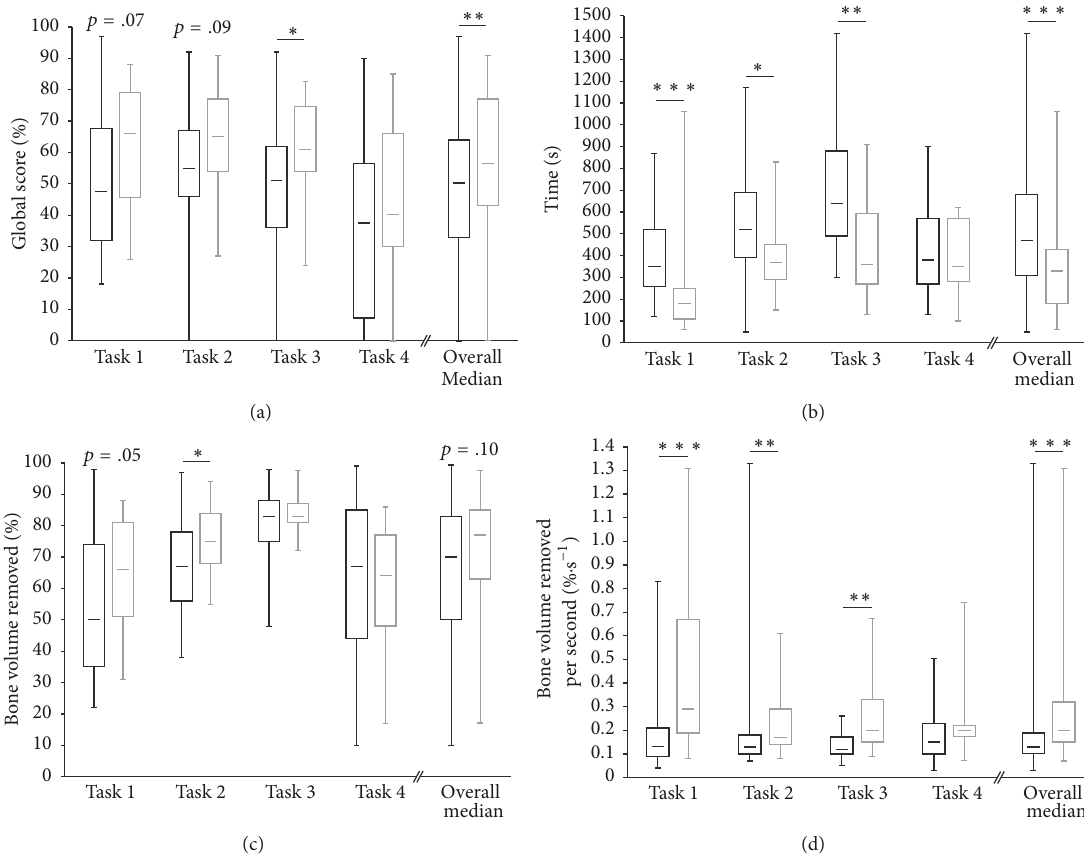
Figure 3: (a) Median global score, (b) time, (c) bone volume removed, and (d) the ratio of bone volume removed per second for the novice group (white bar) and expert group (grey bar). ∗ Significant difference between the two groups ( ∗ 𝑝 < .05 , ∗∗ 𝑝 < .01 , and ∗∗∗ 𝑝 < .001